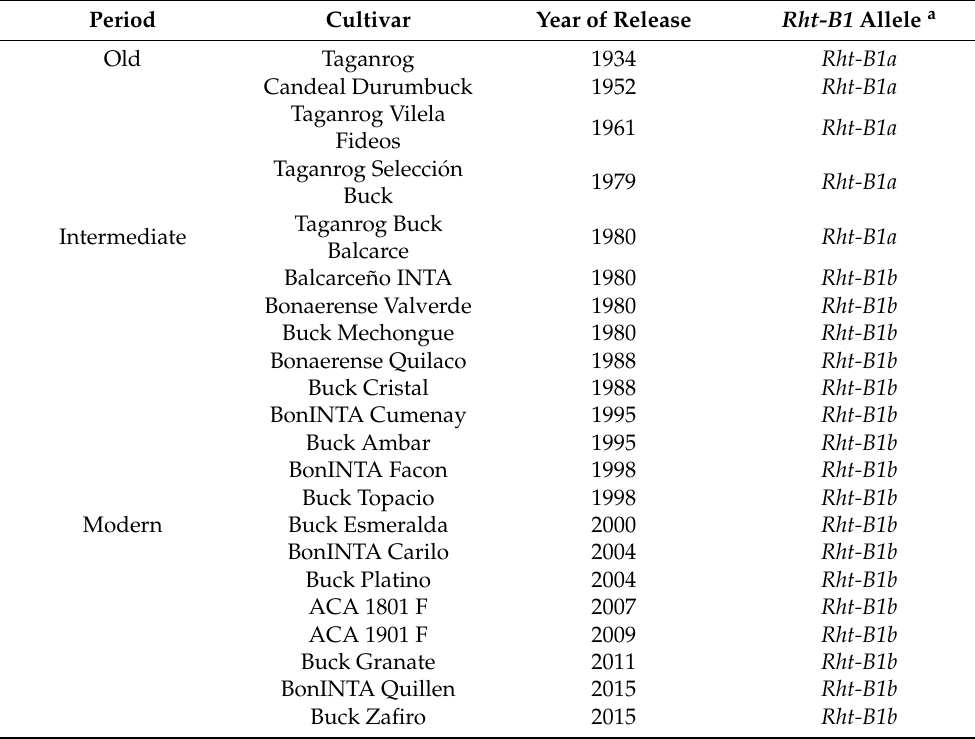
Table 1. Durum wheat cultivars released in Argentina during the 1934–2015 period. Period Cultivar Rht-B1 Allele a Old Taganrog Rht-B1a Candeal Durumbuck